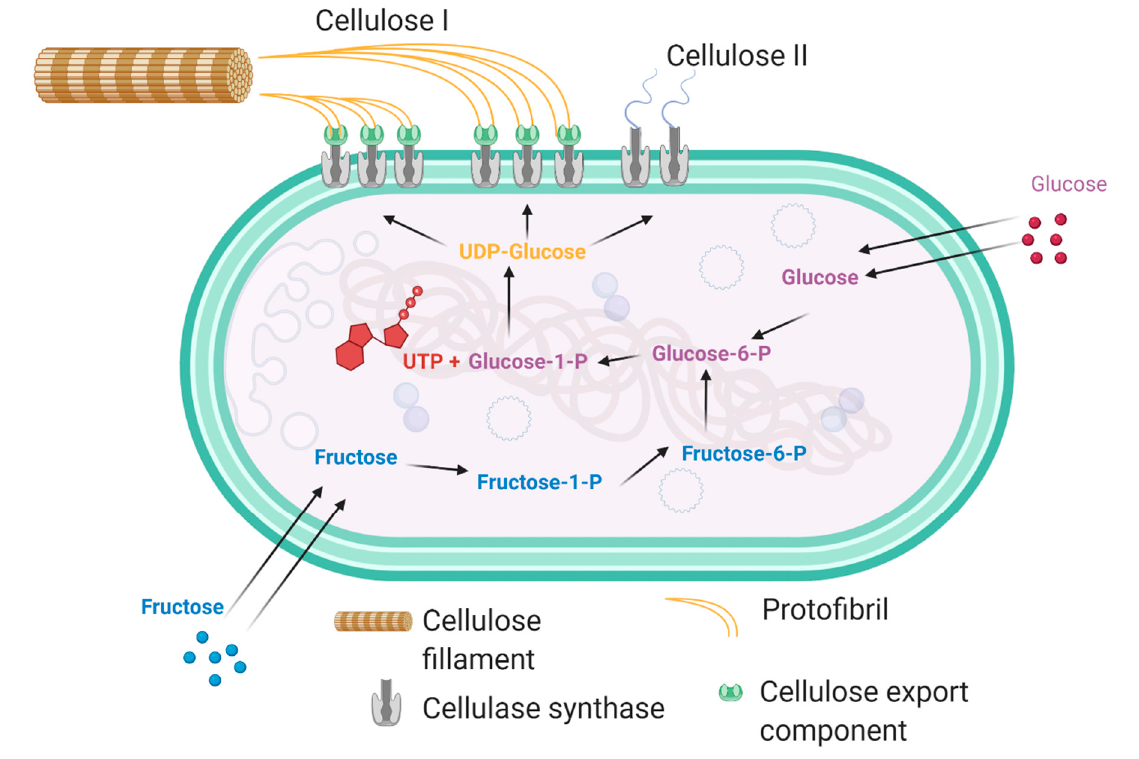
Figure 1. Schematic diagram of the biosynthesis of bacterial cellulose I and II from glucose and fructose.